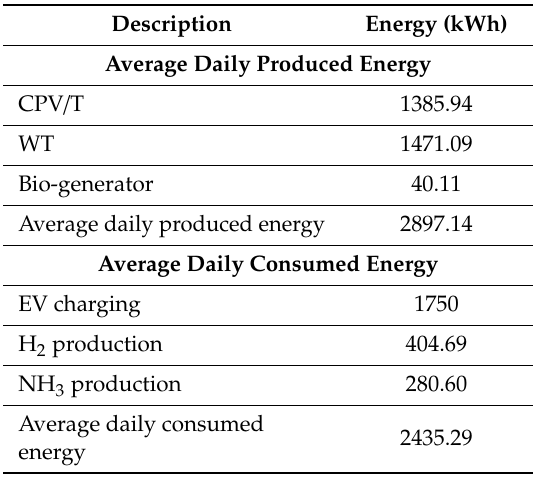
Table 5. Average daily produced and consumed energy.